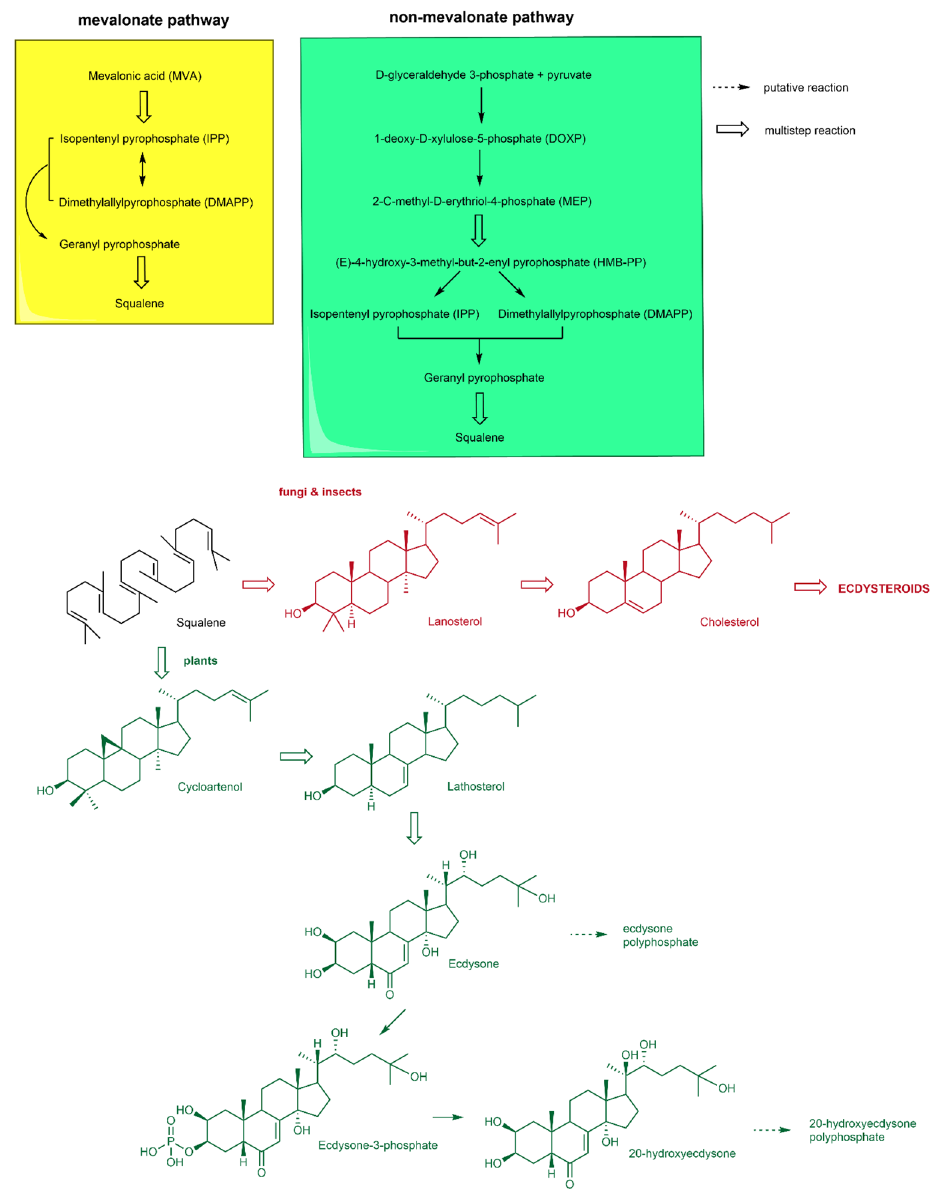
Figure 3. Biosynthesis of phytoecdysteroids.